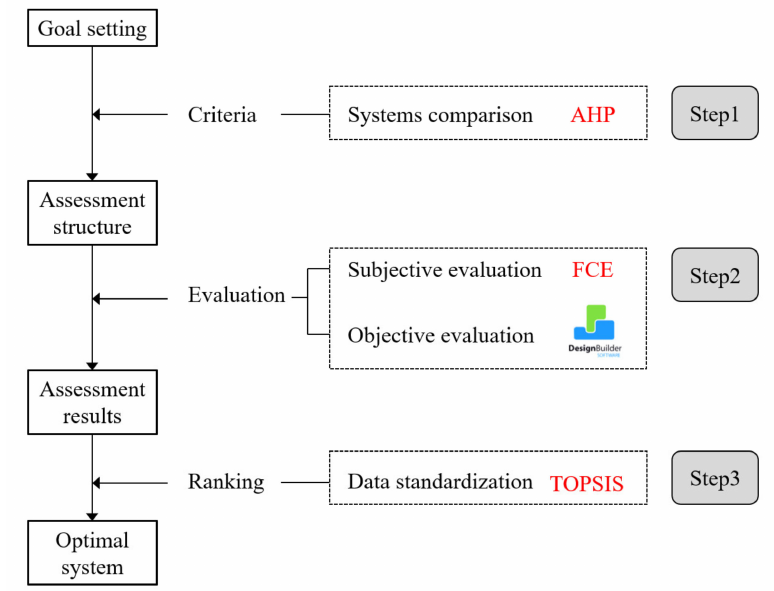
Figure 2. The assessment